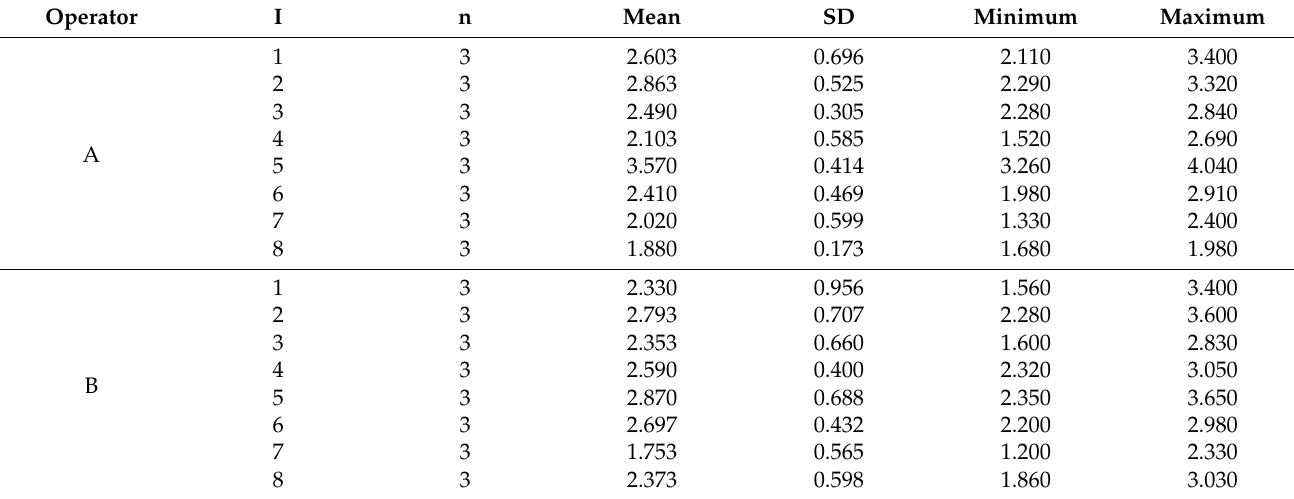
Table 2. Descriptive statistics of the lineal distance of the palatine suture expansion through palatine rapid maxillary expansion technique between operators.